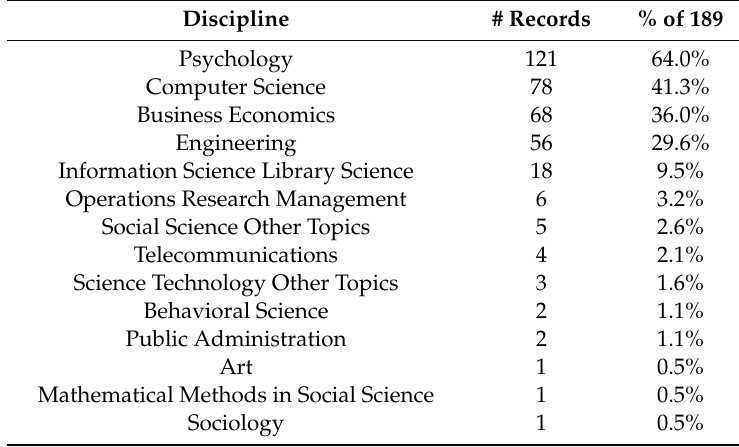
Table 1. Number of UX publications per discipline. Source: Own elaboration based on WoS.